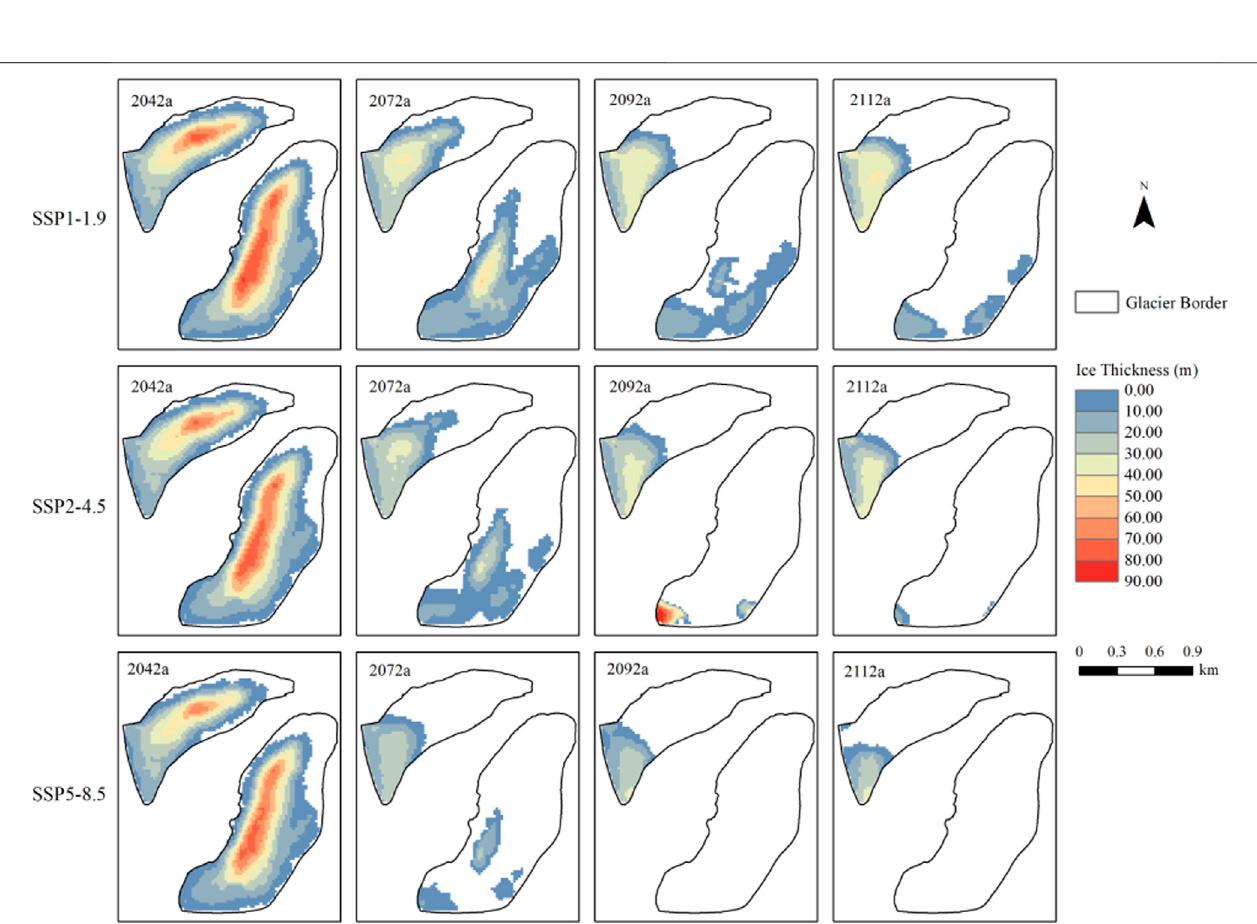
FIGURE 9 | Simulated glacier area and thickness results in different years: the 30th year (2042), the 60th year (2072), the 80th year (2092), and the 100th year (2112) in the SSP1-1.9, the SSP2-4.5, and the SSP5-8.5 scenarios.